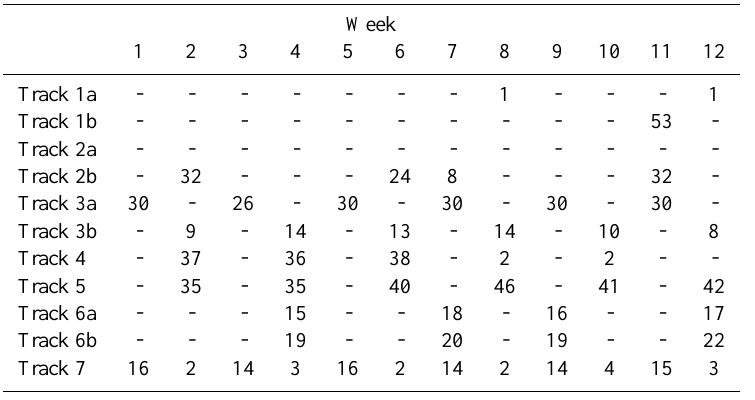
Table 3. VT sampling strategy: numbers of XBTs deployed along each track per week, corresponding to a data assimilation cycle. Dashes mean “zero”. The track design is shown in Fig. 1. Track 6a starts in Piraeus instead of Thessaloniki as originally planned